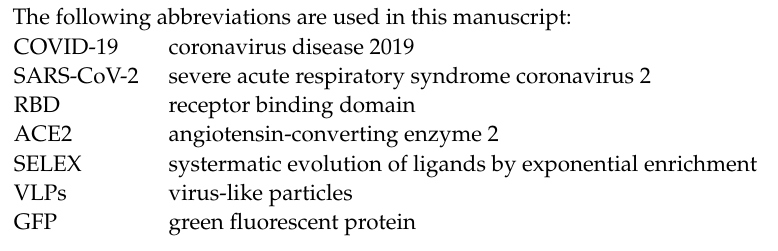
Figure S2. ELISA based binding assay of selected ap-tamers with high salt wash; Figure S3. Concen- tration dependent inhibition of SARS-CoV-2 trimer S protein binding to Vero E6 cells by selected aptamers; Figure S4. Specificity assessment of selected aptamers using SPRi; Figure S5. Flow cytome- try based binding assay of SARS-COV-2 trimer S protein to Vero E6 cells; Figure S6. ACE2 receptor expression on the surface of transfected HEK293T cells; Figure S7. Heatmap plot of the similarity between our selected aptamers and the aptamers reported by Huang et al.; Figure S8. Heatmap plot of the similarity between our selected aptamers and the aptamers reported by Song et al.; Figure S9. Heatmap plot of the similarity between our selected aptamers and the aptamers reported by Gupta et al.; Figure S10. Heatmap plot of the sim-ilarity between our selected aptamers and the aptamers reported by Schmitz, Anton, et al.; Figure S11. Heatmap plot of the similarity between our selected aptamers and the aptamers reported by Sun, Miao, et al.; Figure S12. Heatmap plot of the similarity between our selected aptamers and the aptamers reported by Peinetti, Ana S., et al.; Figure S13. Heatmap plot of the similarity between our selected aptamers and the aptamers reported by Zhang, Zijie, et al.; Figure S14. Heatmap plot of the similarity between our selected aptamers and the aptamers reported by Kacherovsky, Nataly, et al.; Figure S15. Heatmap plot of the similarity between our selected aptamers and the aptamers reported by Liu, Xiaohui, et al.; Figure S16. Heatmap plot of the similarity between our selected aptamers and the aptamers reported by Li, Jiuxing, et al.; Table S1: Sequences of aptamers used in cell-based in-hibition